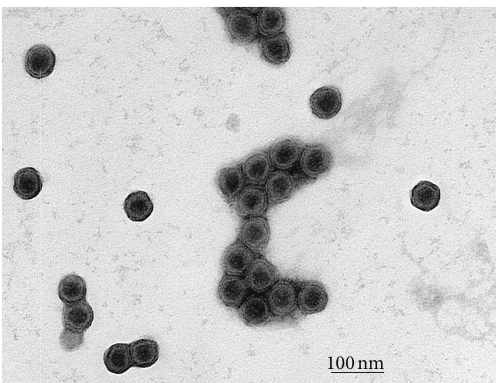
Figure 1: Purified PH1 virus examined by negative-stain electron microscopy. Particles were stained with 2% (w/v) uranyl acetate. Scale bar represents